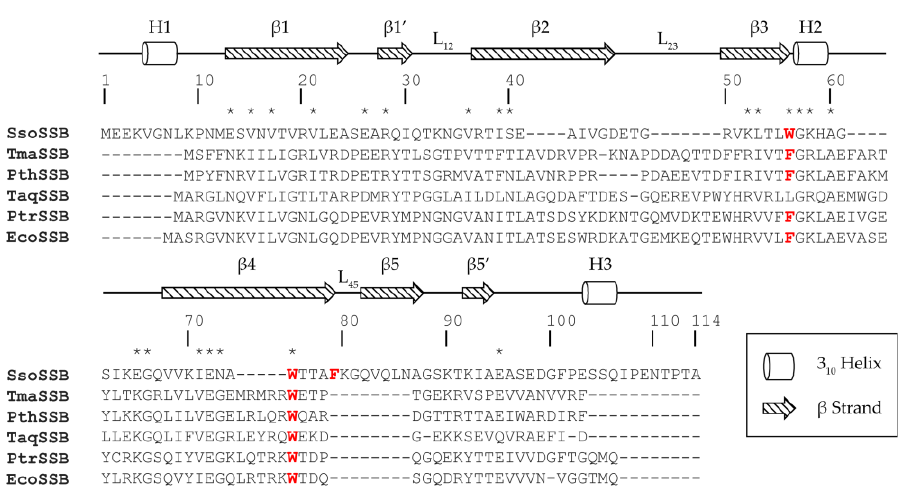
Figure 1. Sequence alignment of SsoSSB with SSBs from various bacteria: hyperthermophilic Thermotoga maritima (TmaSSB) and Pseudothermotoga thermarum (PthSSB); thermophilic Thermus aquaticus (TaqSSB), and Pseudoalteromonas translucida (PtrSSB); mesophilic Escherichia coli (EcoSSB). Conserved residues are indicated with an asterisk. Aromatic residues participating in base-stacking upon DNA binding are colored red. The secondary structure of SsoSSB from UniProt [21] and a previous study [14] are depicted above the sequence.